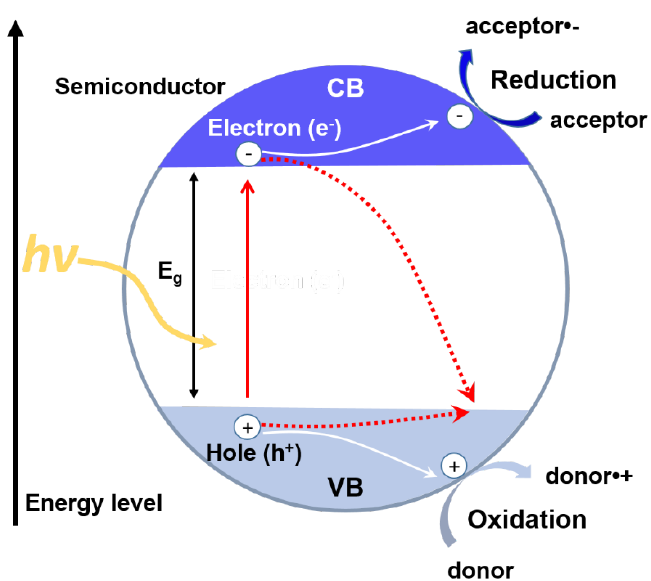
Figure 1. Schematic illustration demonstrating the photocatalytic process of a semiconductor photocatalysts. Adapted with permission from Reference [22]. Copyright (2011) Elsevier.